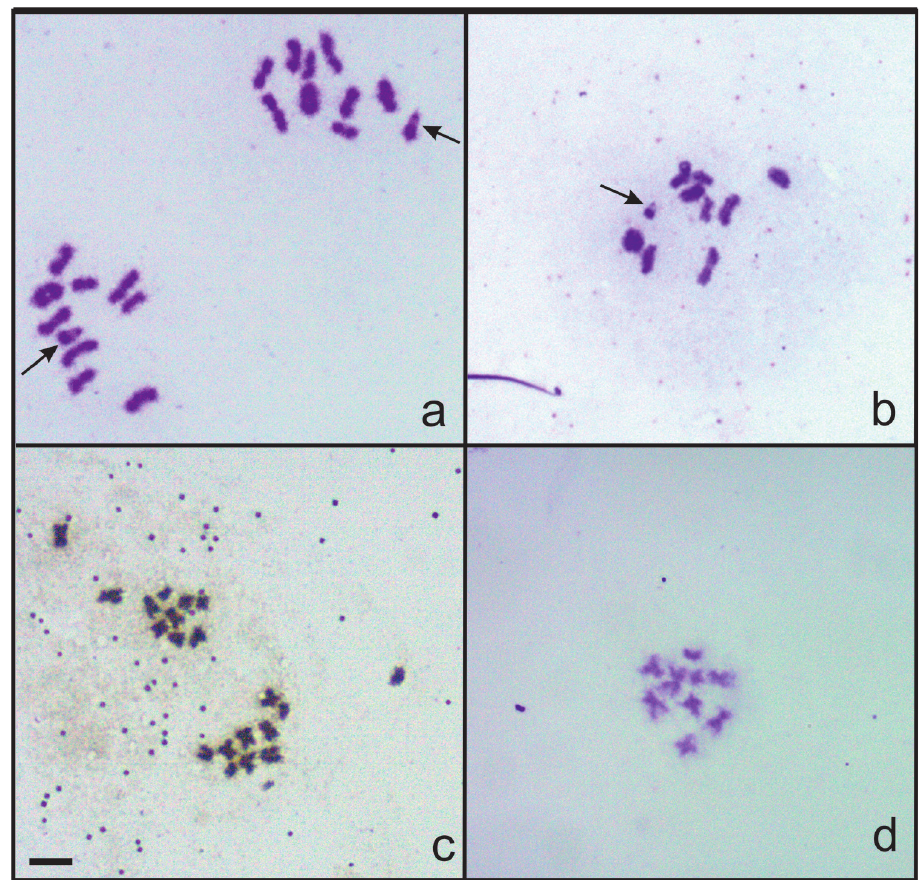
Figure 4. a–b metaphase I a N. bozdagus b N. plebejus c–d metaphase II c N. bozdagus d N. plebejus . Arrows show Xy sex bivalents, Bar = 5 p